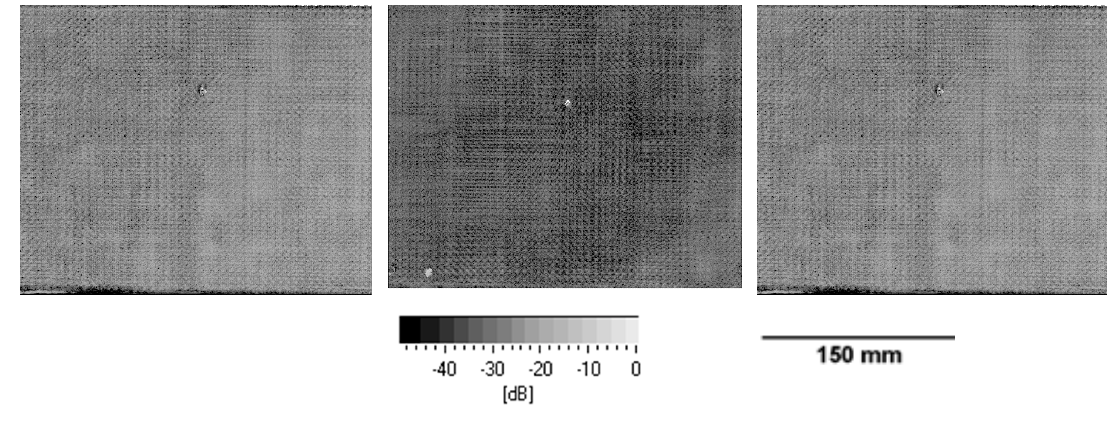
Figure 4. C-scans (flaw-echo) of the laminates (2 mm laminate thickness) cured with hardeners TETA, IPDA, and DDS (left to right).